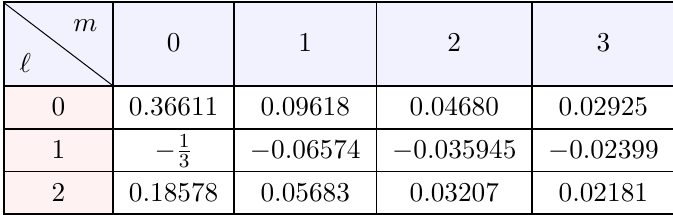
Table 2 . The anomalous dimension γ ( m, ‘ ) for ‘ = 0 , 1 , 2 and m = 0 , 1 , 2 , 3 .